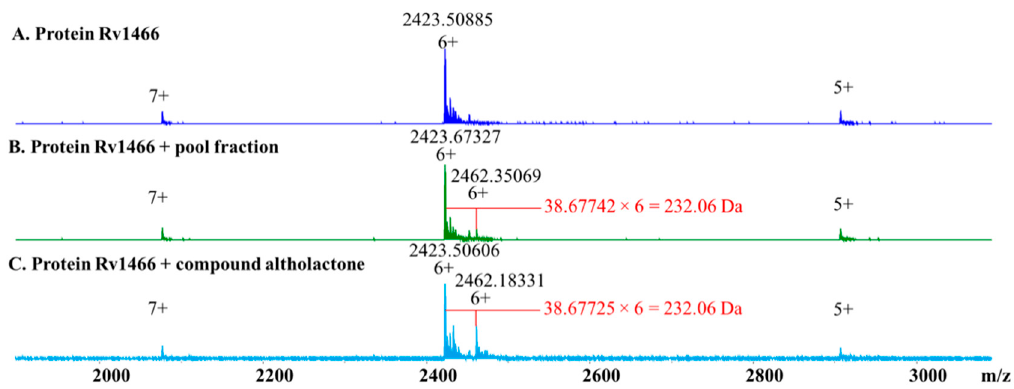
Figure 3. Native MS spectra of ( A ) Rv1466; ( B ) Rv1466 mixed with a pool fraction; and ( C ) Rv1466 mixed with pure isolated altholactone. The same binding ligand with molecular weight 232.06 Da was identified from both the pool fraction and pure compound altholactone.